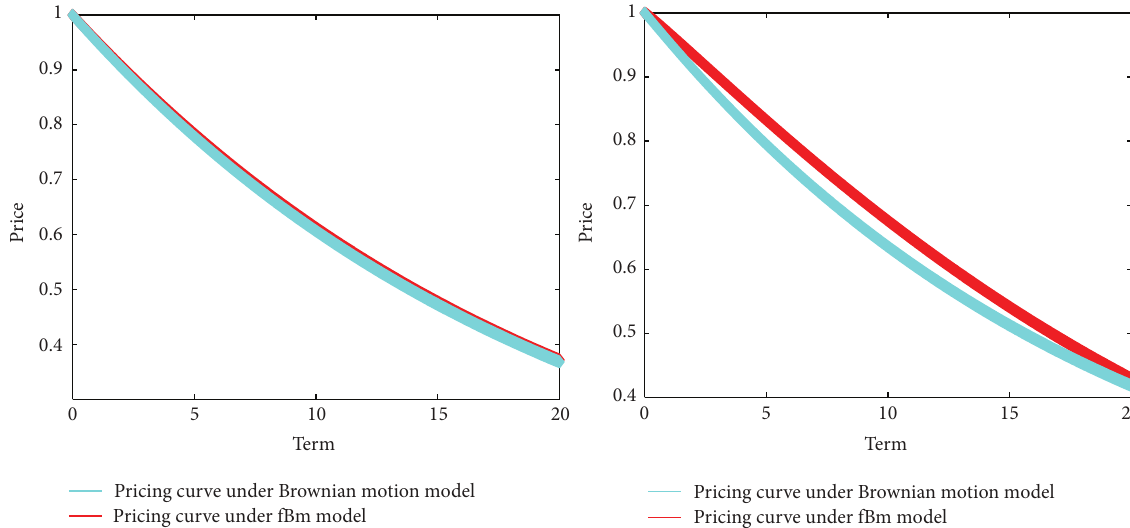
Figure 1: Comparison pricing 𝑃 𝛼 as a function of 𝑇 given 𝜎 = 20 %, 𝑟 = 5 %, 𝛿 = 2 %, and 𝐾 = 0.9𝑒 0.03𝑇 , for 𝛼 = 0.2, 0.3 , respectively.